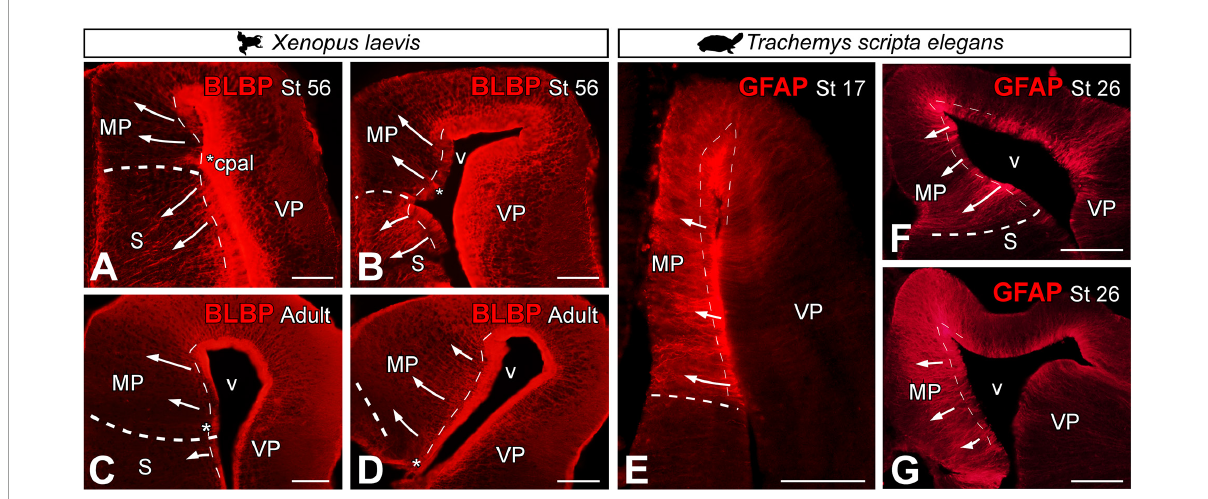
FIGURE3 Photomicrographs of transverse sections through the telencephalon of Xenopus laevis (A–D) and Trachemys scripta elegans (E–G) at the stages indicated in each photomicrograph, showing the direction of the radial glia in both models (arrows) by BLBP in X. laevis and GFAP in T. scripta . The asterisks indicate the pallial commissure. The thin dotted lines point to the ventricular surface and the thick dotted lines to the pallium-subpallium boundary. Scale bar = 200 µ m. See the abbreviation list.